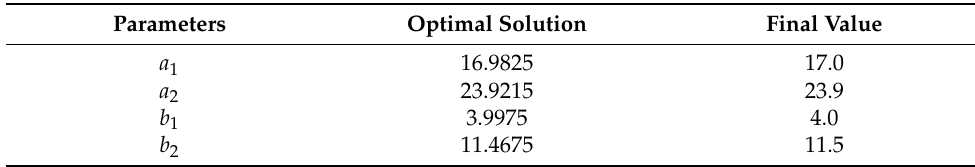
Table 6. Optimal solution and final value of each response variable.